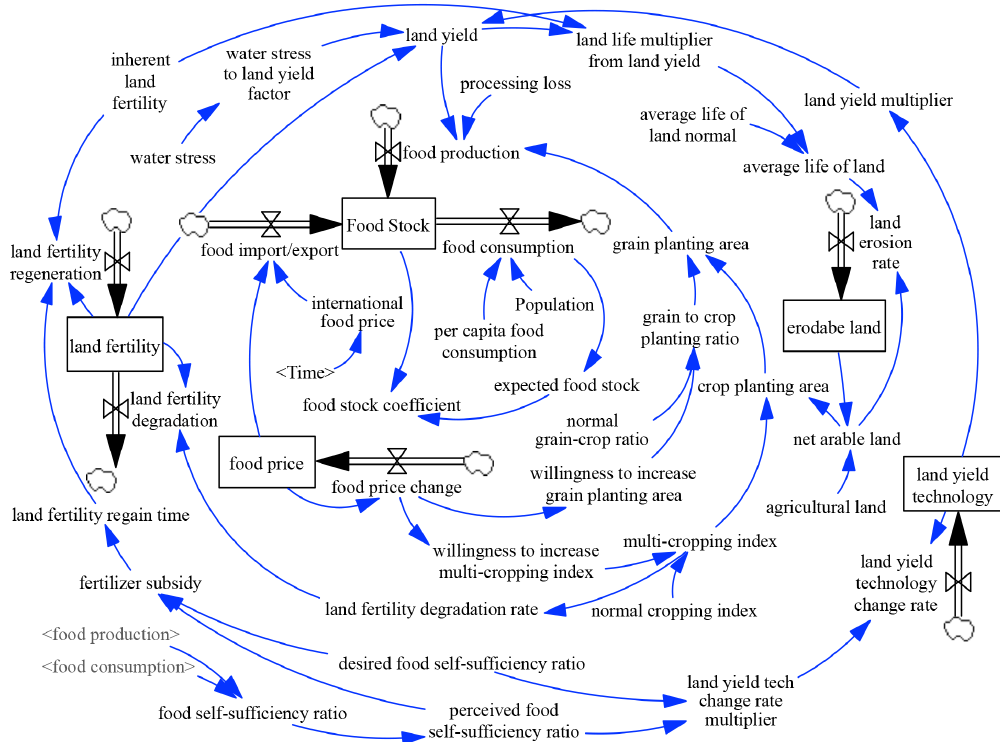
Figure 13. Stock and flow diagram of the food